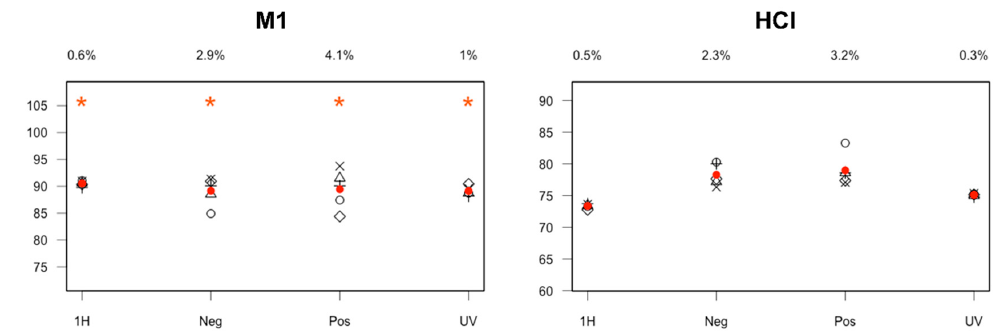
Figure 2. API quantification results for M1 and acidic degradation (%; Y axis) using the different analytical techniques ( 1 H-NMR, ESI: negative and positive ion mode, UV at 275 nm; X axis) and for 5 replicates ( ⨯ , ◊ , ○ , +, ∆ with ● representing the mean value). The coefficient of variation (CV) values (%) are specified at the top. * indicates that significance tests were successfully passed for reconstituted mixtures where theoretical values are available.